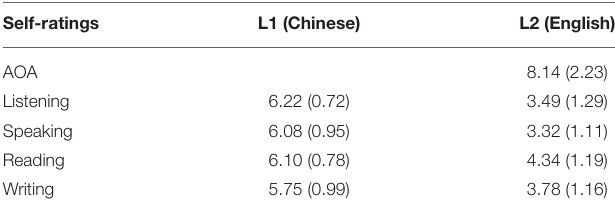
TABLE 1 | Means (and SDs) of language proficiency self-ratings and age of acquisition (AOA).